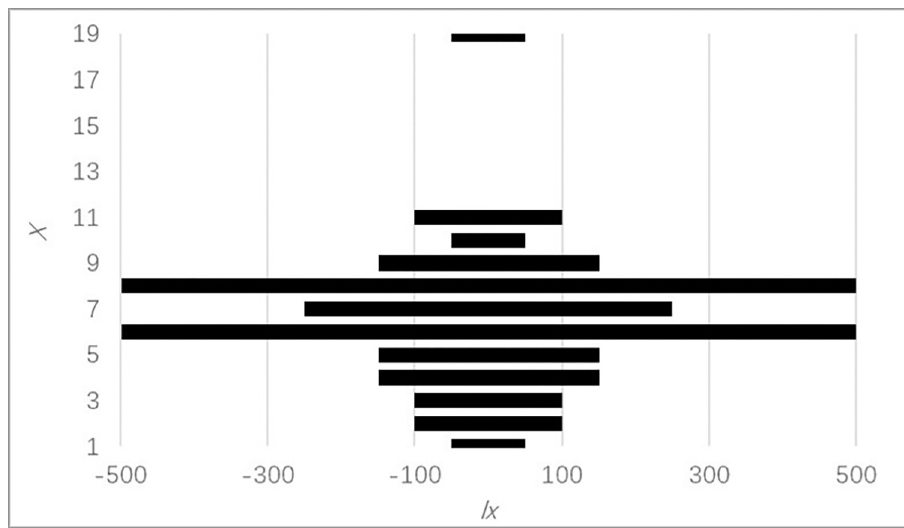
Fig 3. Age pyramid of P . flavus LM